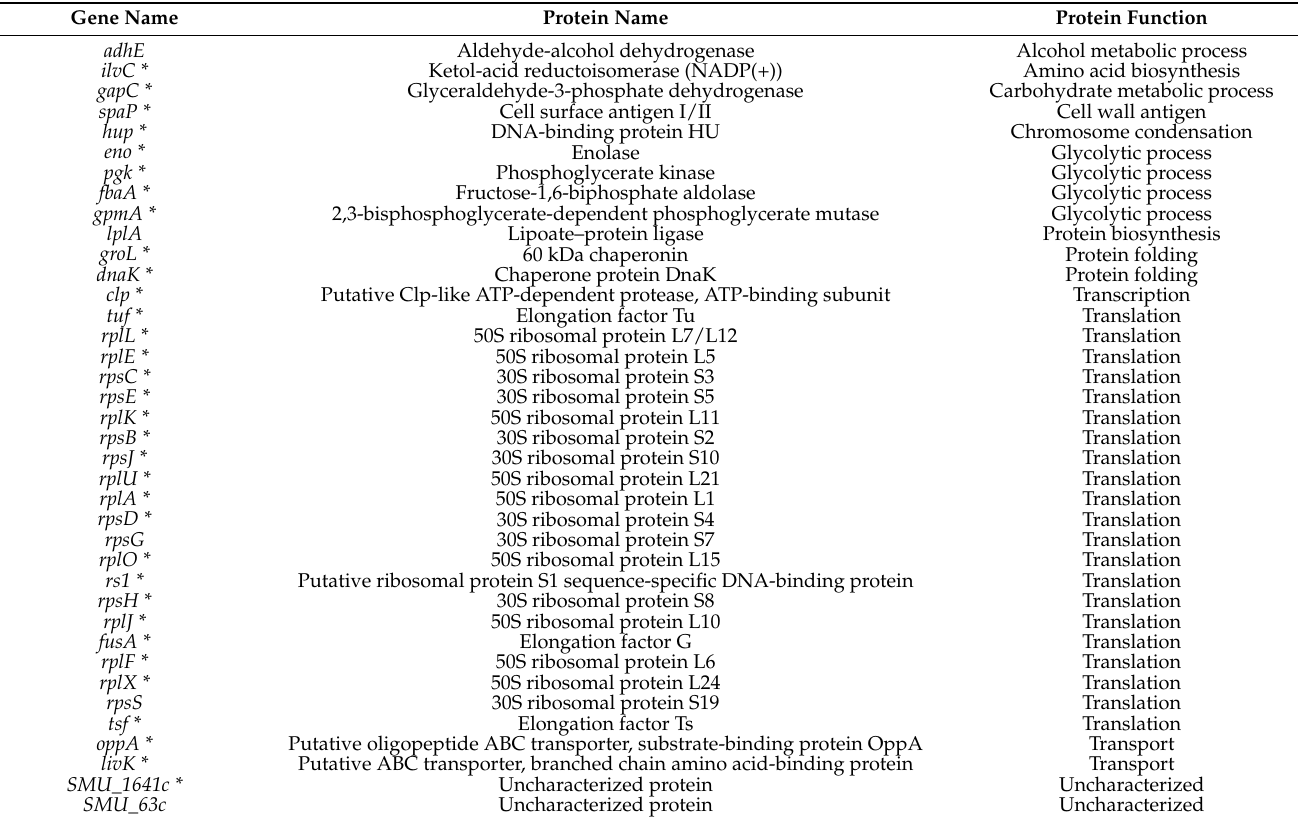
Table 3. S. mutans cell-wall proteome profile at baseline (time point